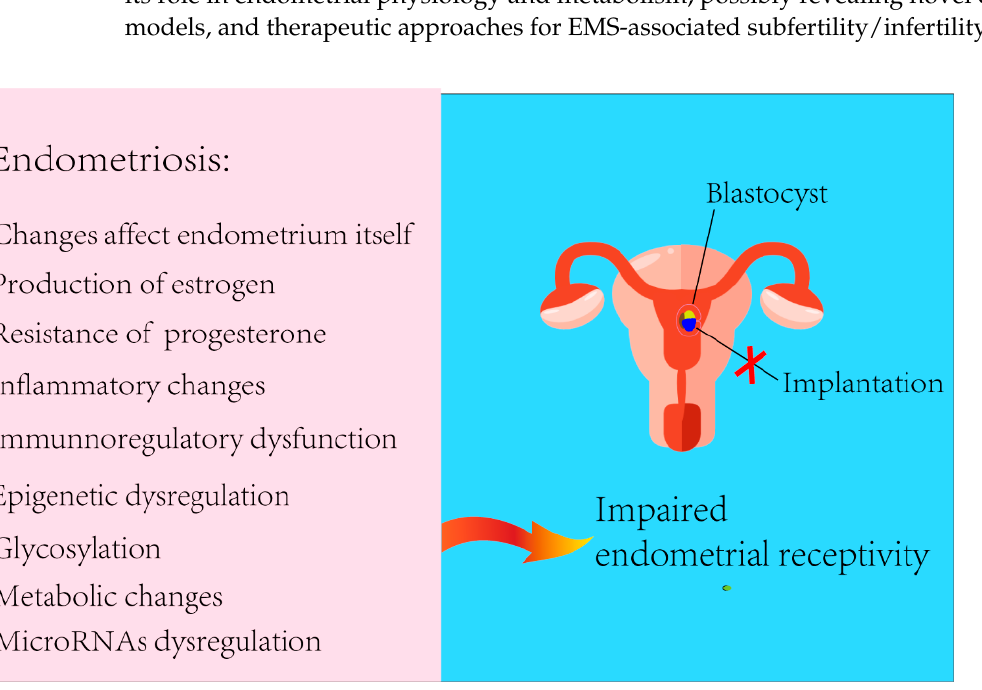
Figure 4. A summary of the pathogenesis of EMS affecting endometrial receptivity.